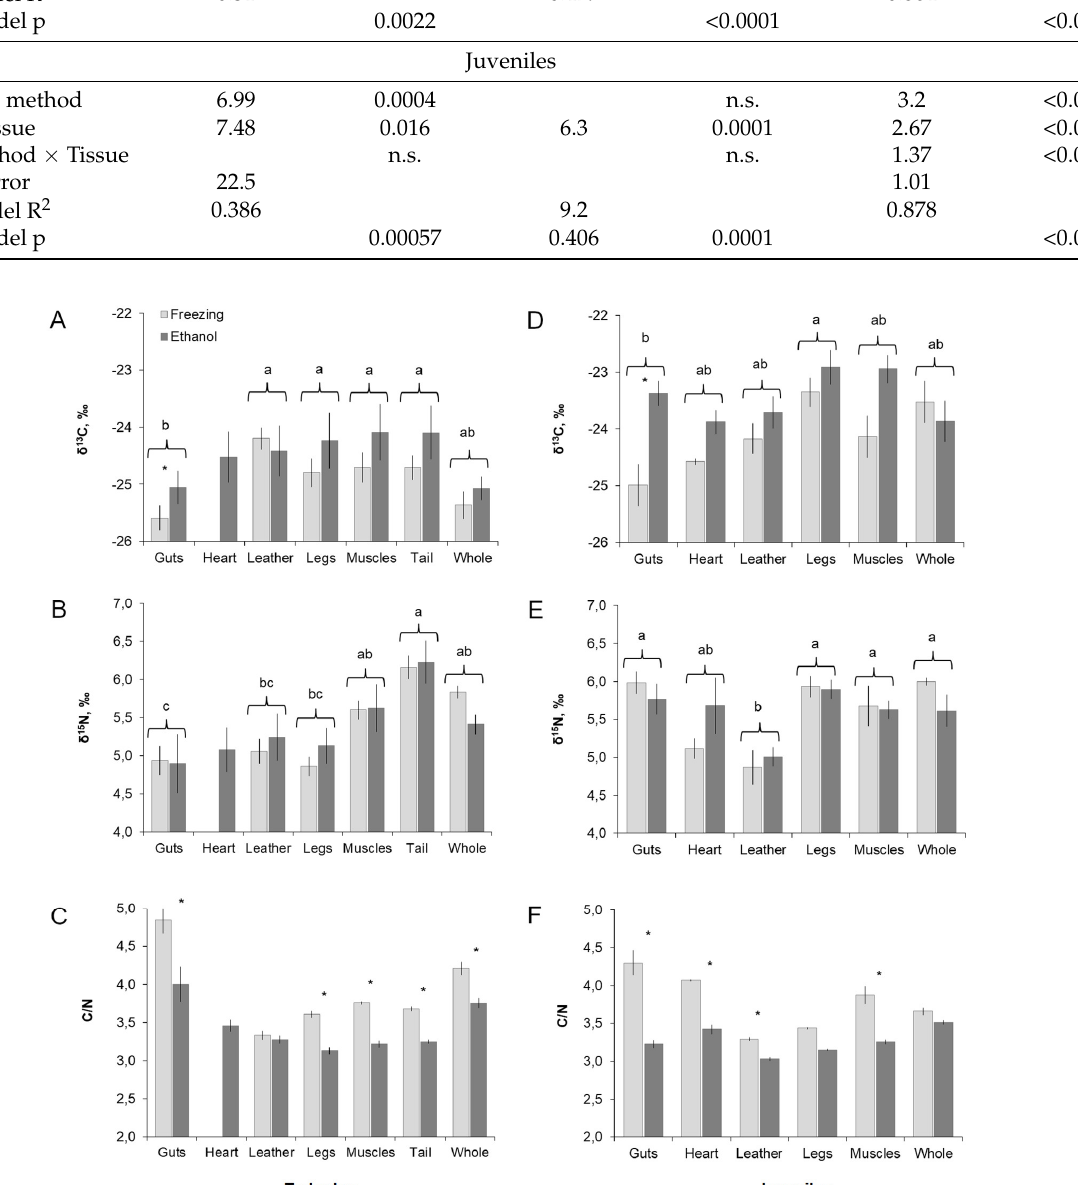
Figure 1. Stable isotope composition δ 13 C, δ 15 N (‰ ± SE) and C/N of B. bufo tadpoles ( A – C ) and juveniles ( D – F ). Asterisks indicate significant differences between frozen and ethanol-fixed tissues according to Tukey HSD test after GLM, p < 0.05. Different letters indicate significant differences between mean values of certain type of tissues by Tukey HSD test. Heart of frozen tadpoles was not analyzed.